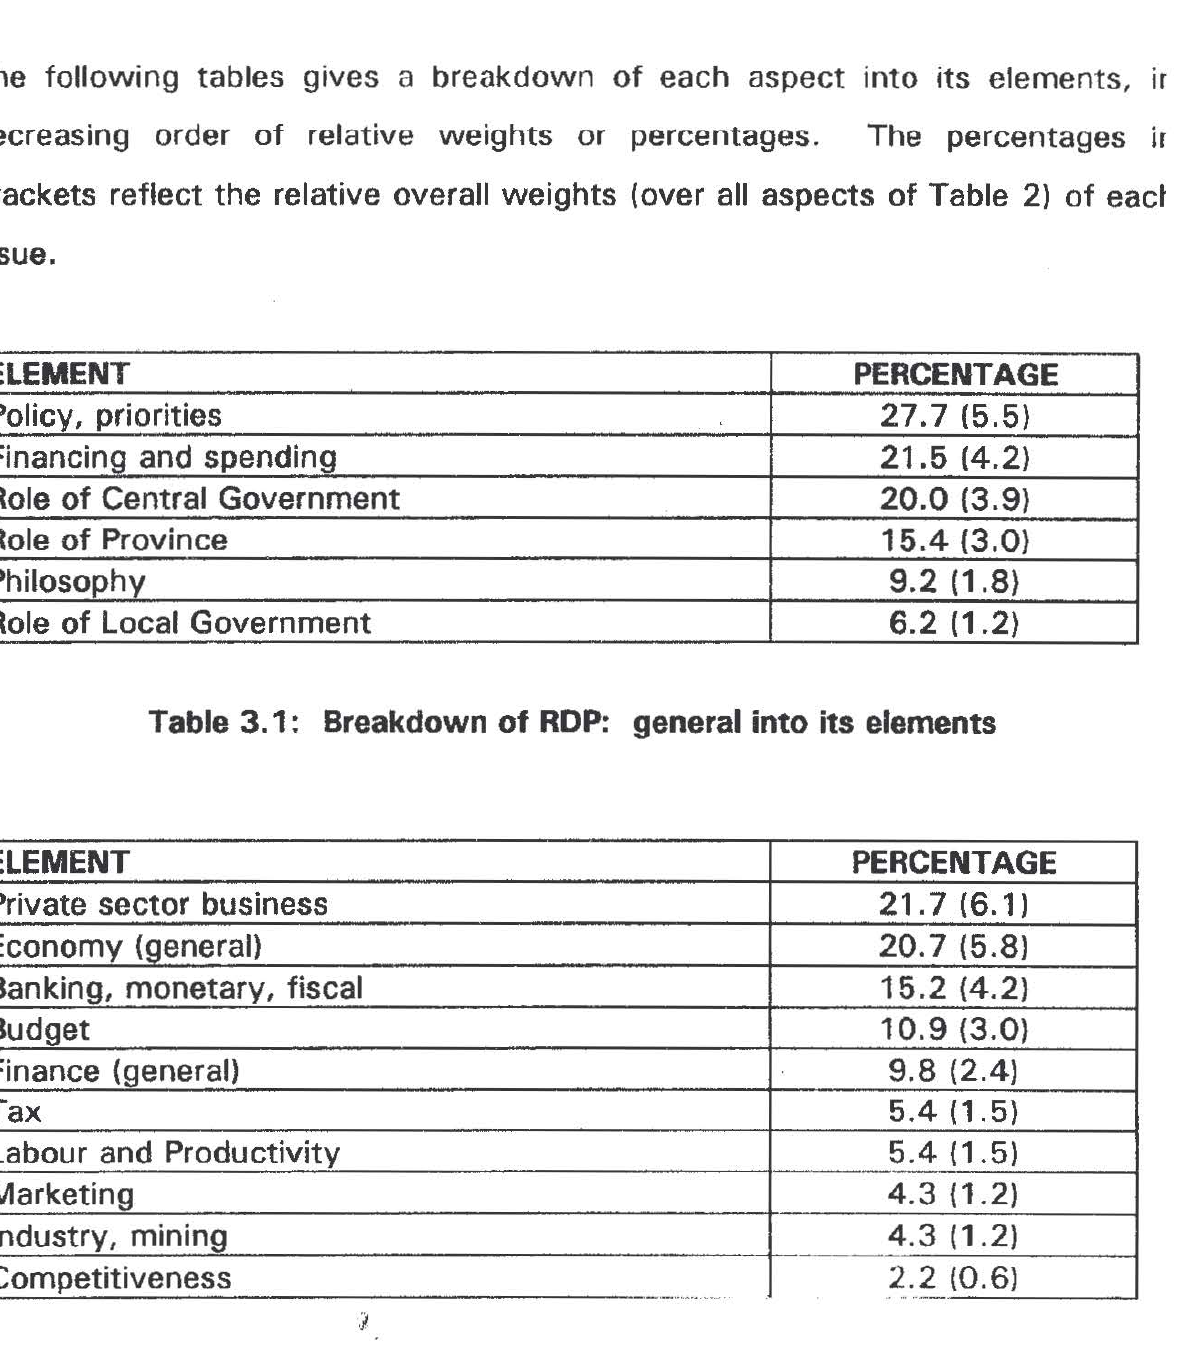
Table 3.2: Breakdown of Financial and Economic